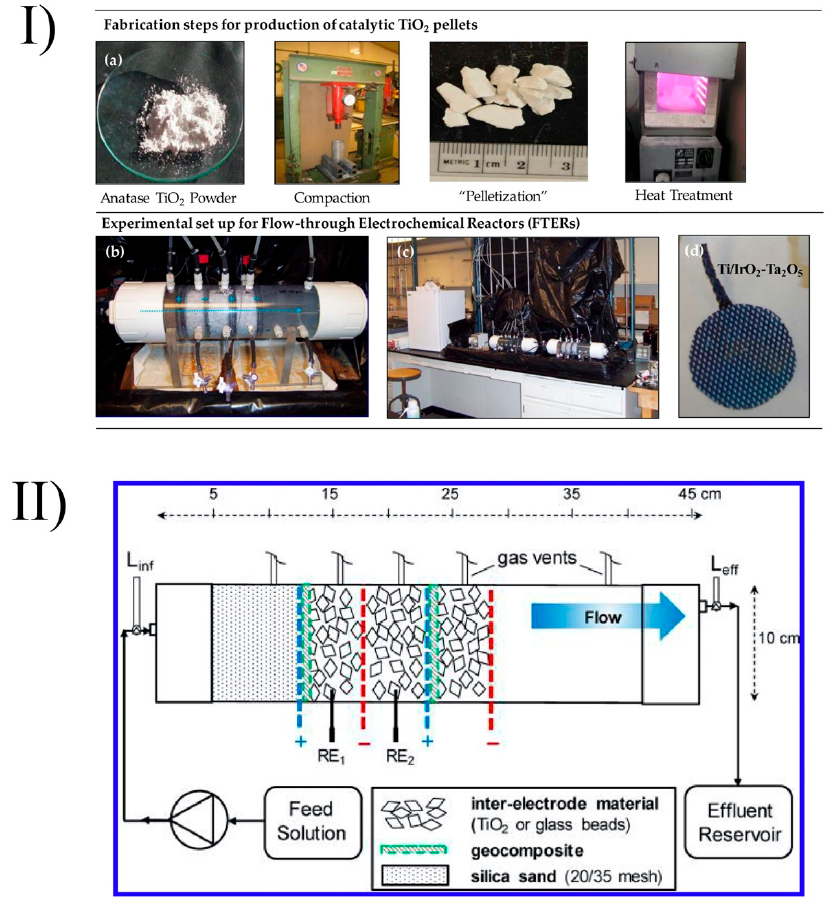
Figure 7. Fabrication steps for production of catalytic TiO 2 pellets ( I ) and scheme of the flow-through electrochemical reactor ( II ). RE are reference electrodes. Reprinted with permission from